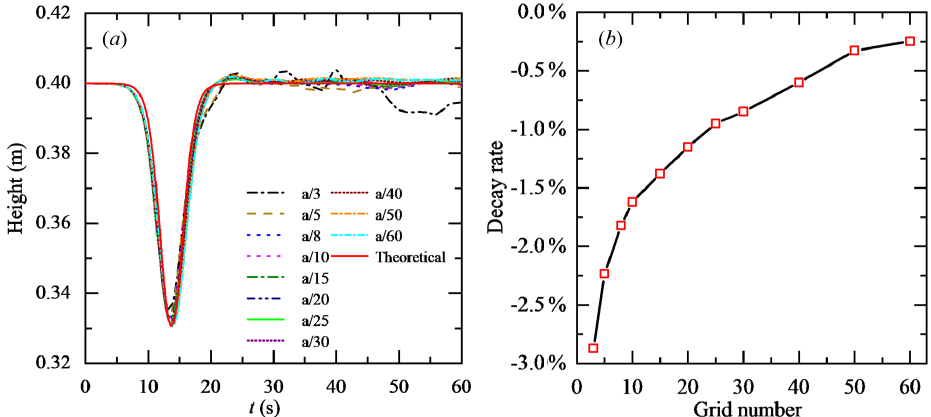
Figure 5. Grid independence analysis in the vertical direction at probe P1: (a) comparison of waveform and (b) decay rate.